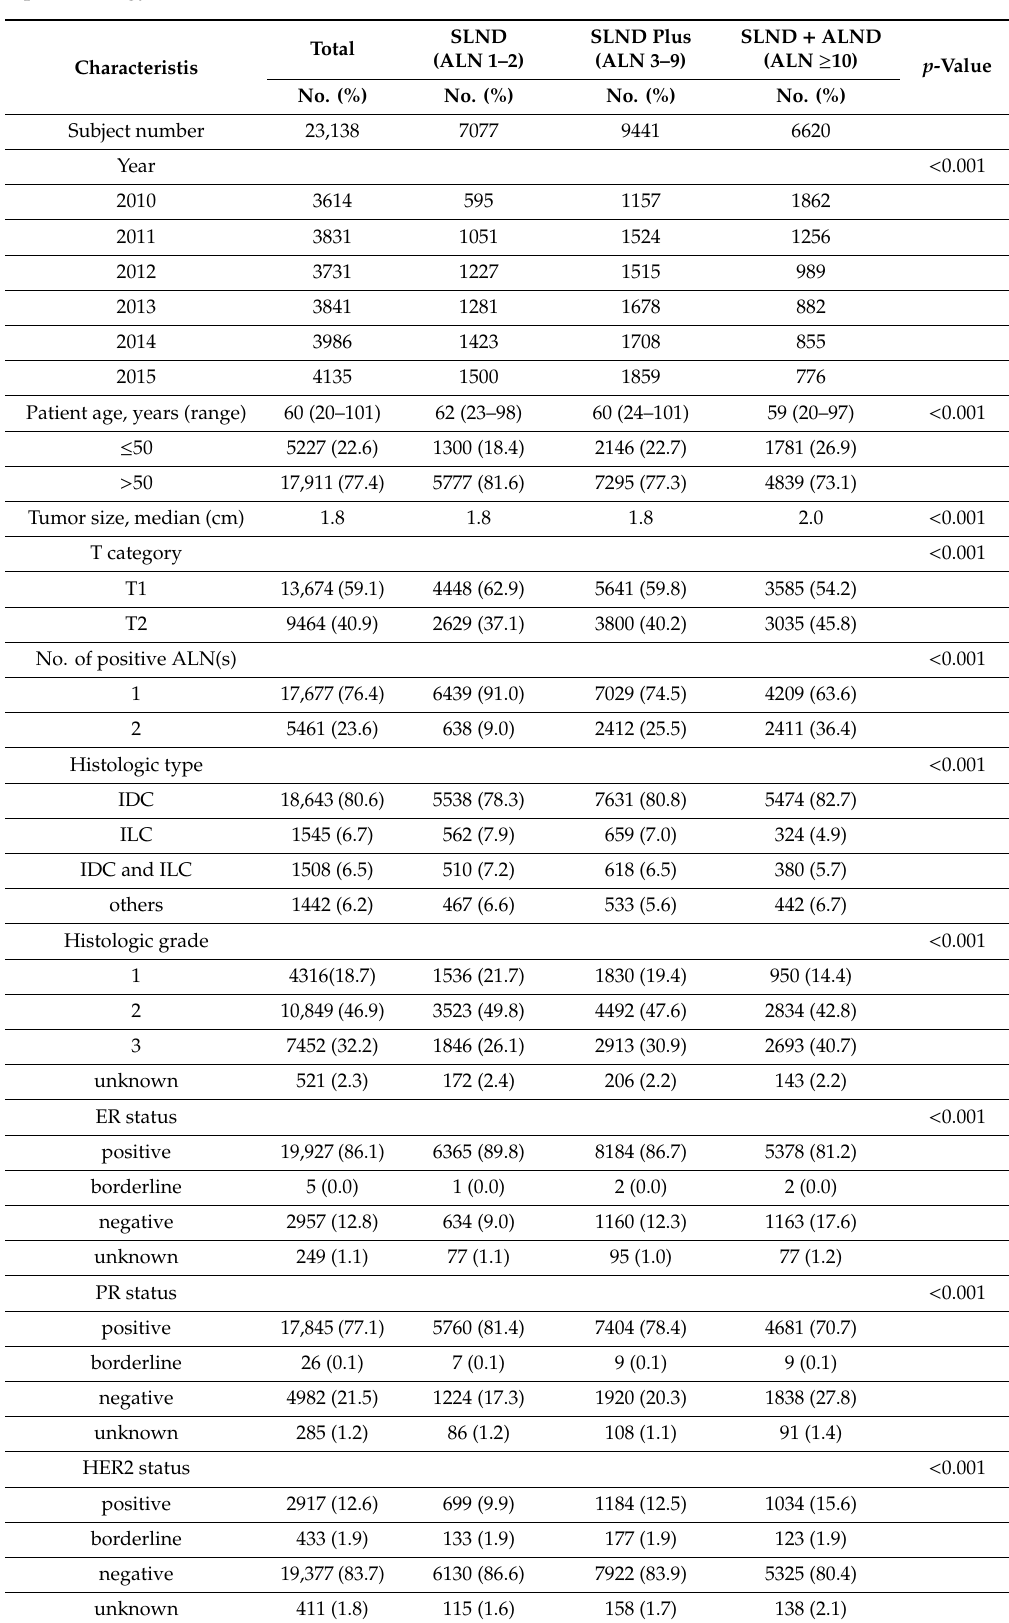
Table 1. Baseline characteristics of the Z0011-compable patients selected from the Surveillance, Epidemiology, and End Results (SEER)